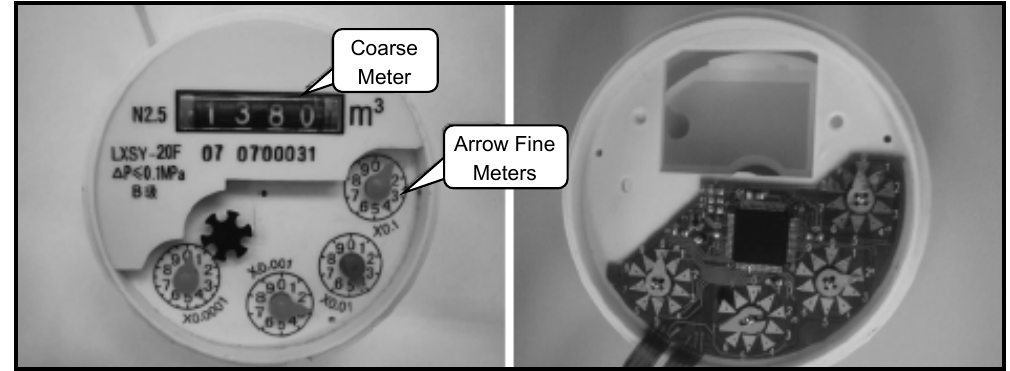
Figure 8. Mechanical meter as a smart meter